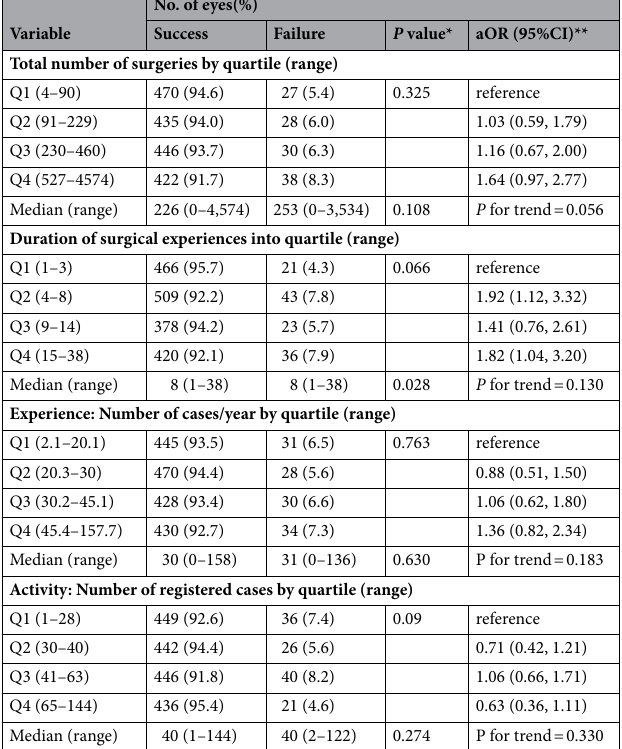
(Supplementary Table S4). For the SB group, the patients’ age ( P = 0.007), prior ocular surgery ( P = 0.015), and lens status ( P = 0.002) were significantly associated with the visual outcome (Supplementary Table S5). Sup-